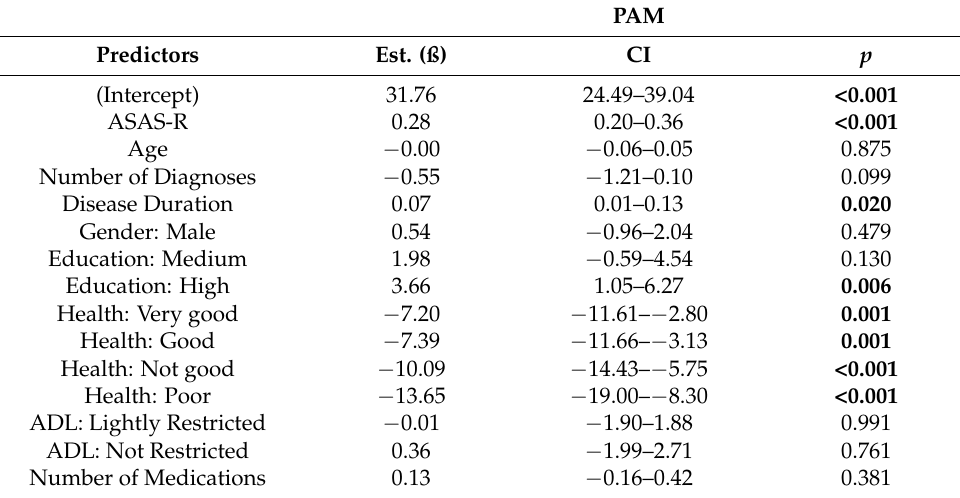
Figure 1. Relationship ( A ) and distribution of ASAS ( B ) and PAM ( C ). Table 4. Linear regression on PAM total